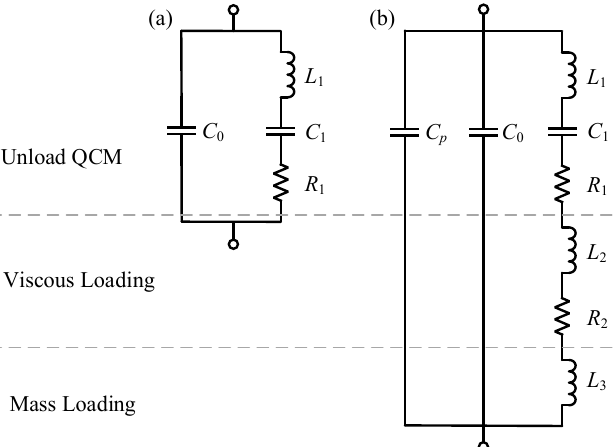
Figure 1. The Butterworth-Van Dyke (BVD) equivalent circuit for ( a ) an unloaded quartz crystal microbalance (QCM); and ( b ) a QCM under viscous and mass loading.